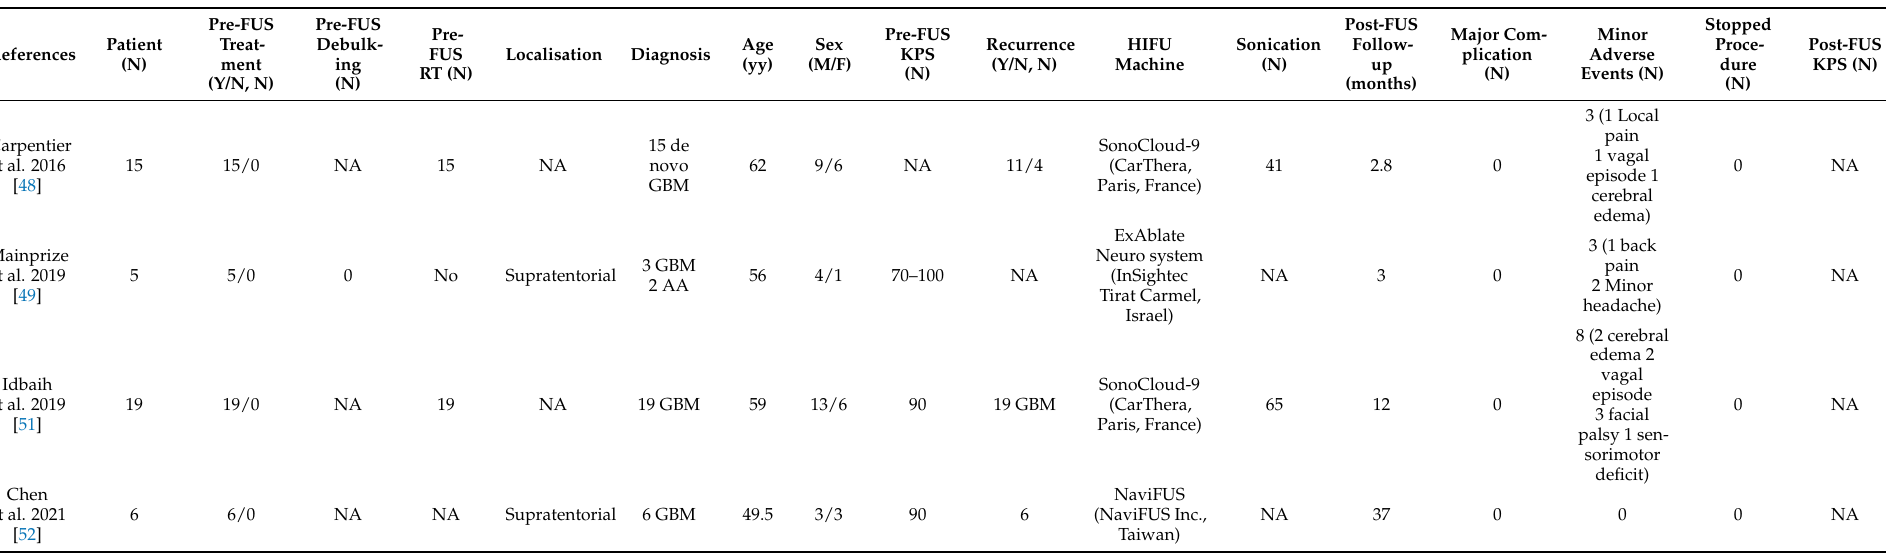
Table 5. Overall BBB Opening via FUS patient demographics, preoperative status and post-operative follow-up.